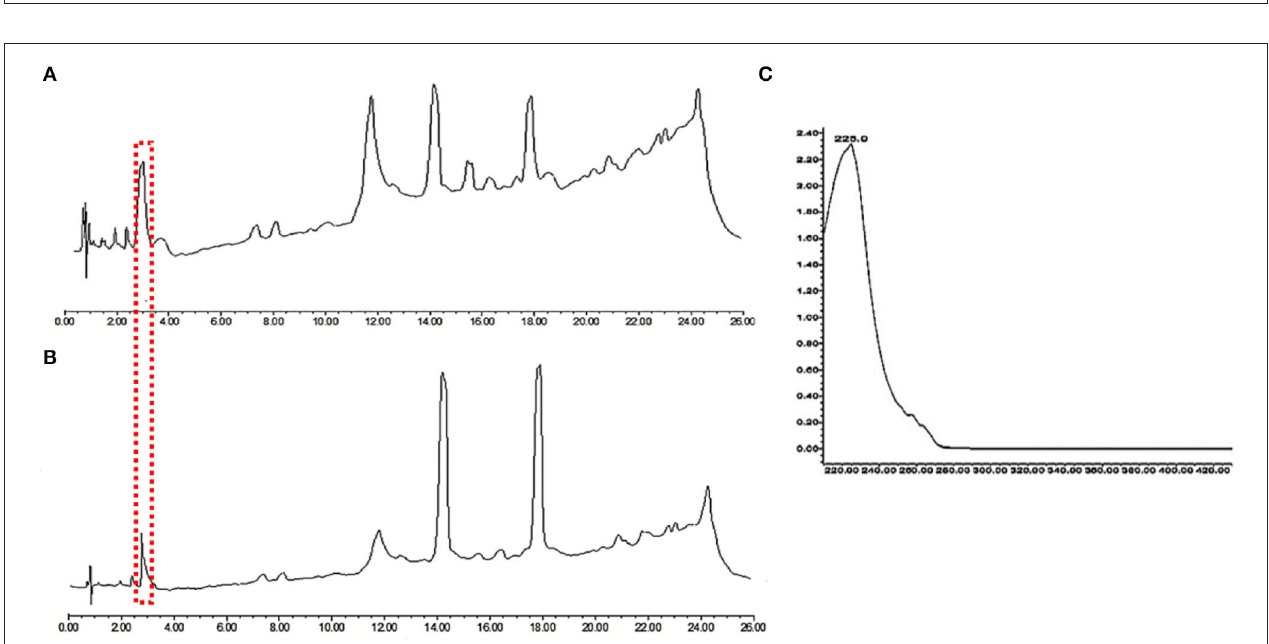
FIGURE 10 | Comparison of PG concentration of the wild-type strain and the 1 abct 31 transformants on the 7th day. (A) PG concentration in mycelium and medium; (B) Comparison of PG concentration affected by supplementation of D-valine, phenylacetic acid, and L-cysteine at 2mM on 7th day. The bar representing the mean of triplicate values and error bars show standard deviation.